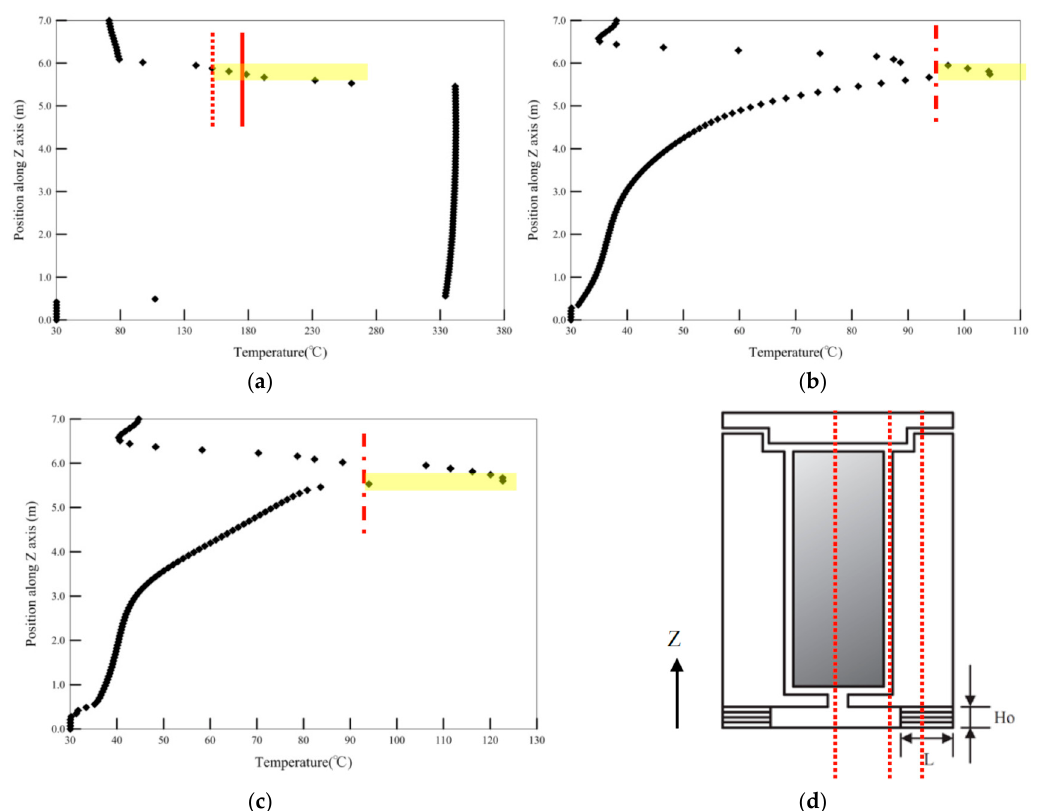
Figure 8. Temperature changes with the height (Z direction) of the dry storage cask (at Y = 3, 2 and 1.5 m sections) (with the 50-cm SPCD) (The heat dissipation rate is 2.6 kW/m 3 . The ambient temperature is 30 °C). ( a ) Y = 3 m section; ( b ) Y = 2 m section; ( c ) Y = 1.5 m section; and ( d ) Sectional profiles at different Y locations.